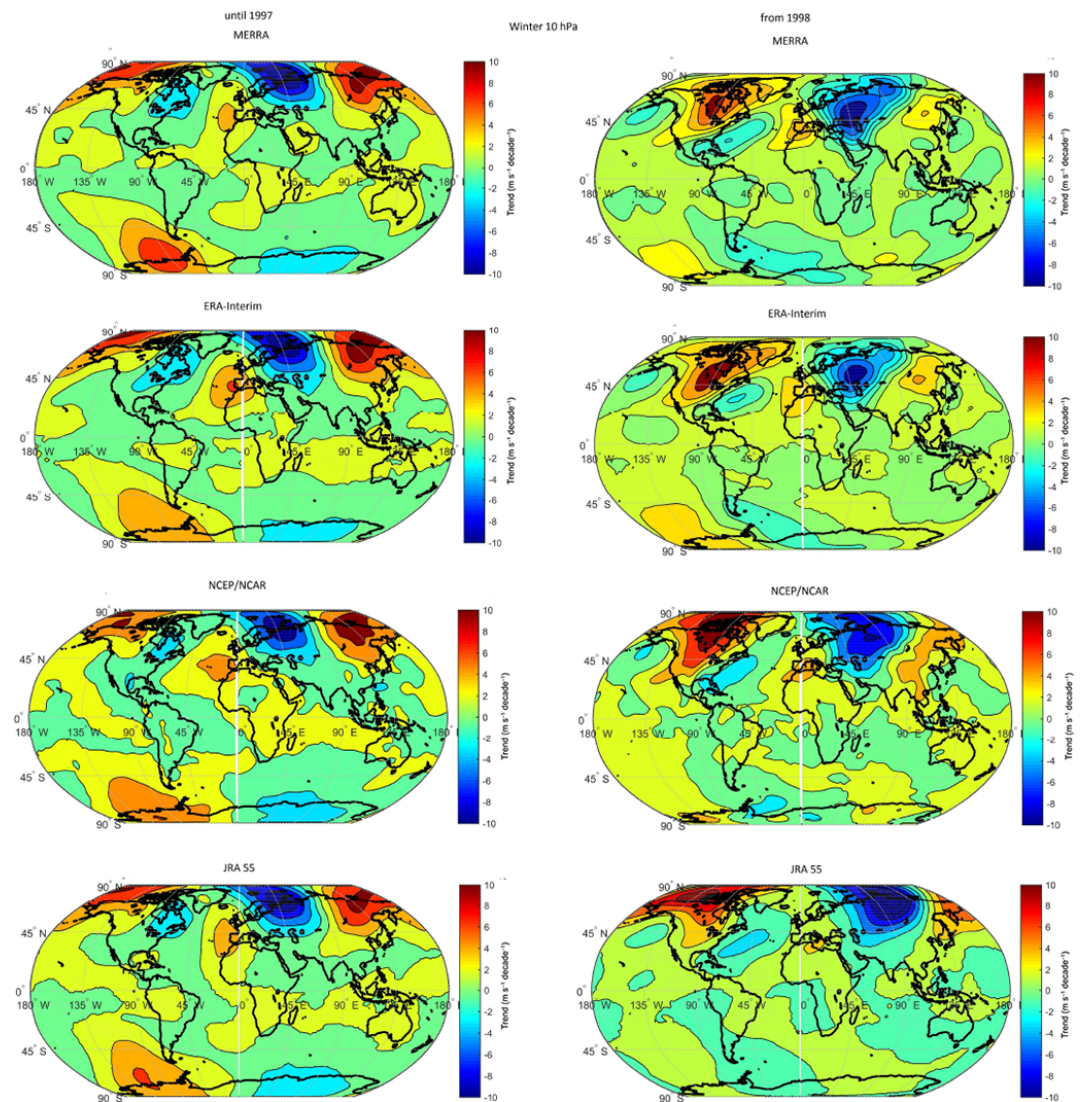
Figure 4. The same as Fig. 3 but for meridional wind trends (ms − 1 decade − 1 ).